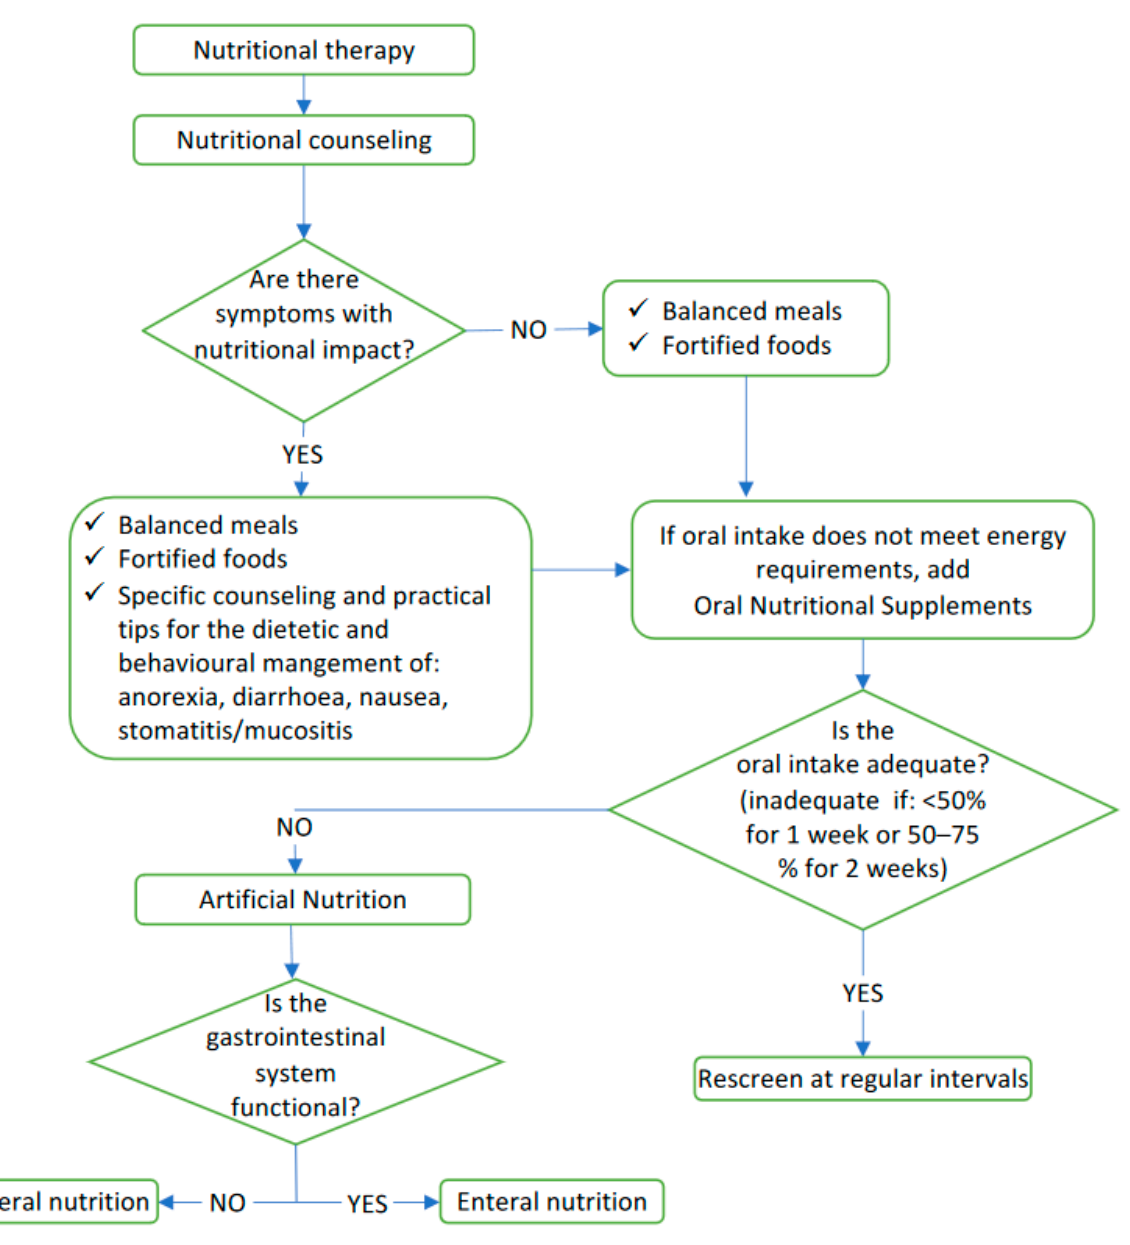
Figure 2. Decisional algorithm for nutritional therapy.